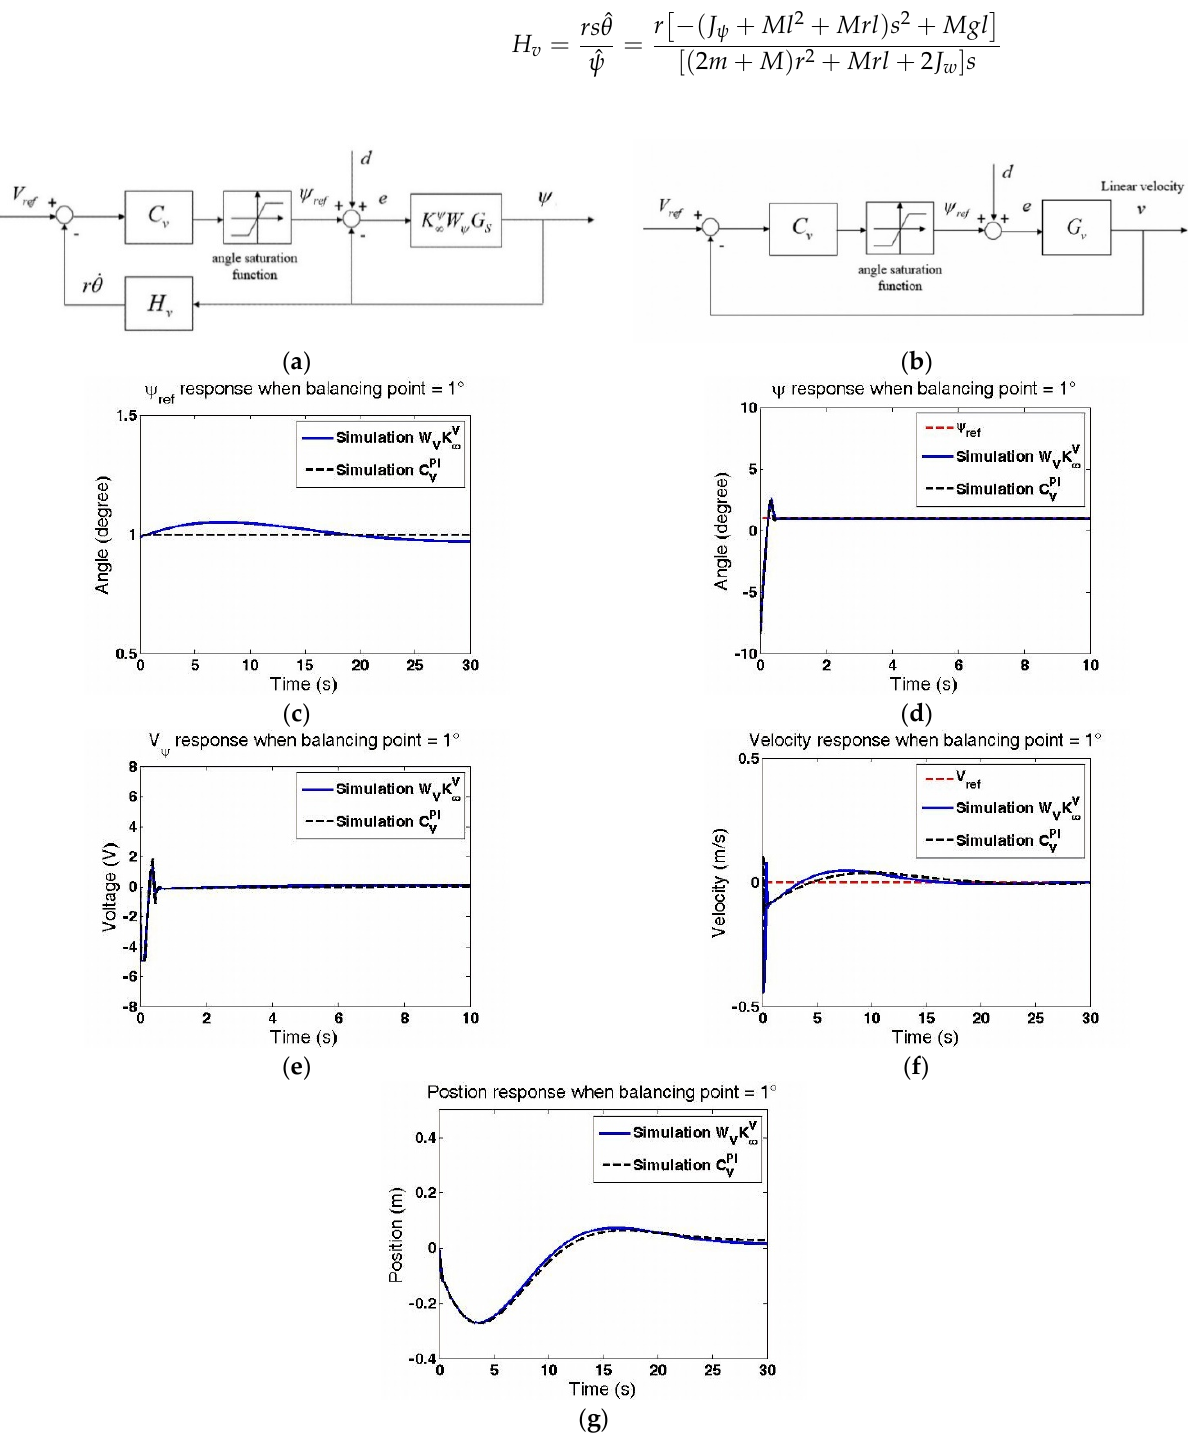
Figure 6. The velocity-loop structure and simulation results with V ref = 0 ( a ) The velocity loop control structure; ( b ) Equivalent velocity control loop; ( c ) Online ψ ref adjustment; ( d ) ψ responses; ( e ) control signal V ψ ( t ) ; ( f ) Velocity responses v ( t ) ; ( g ) Position responses p ( t ) .